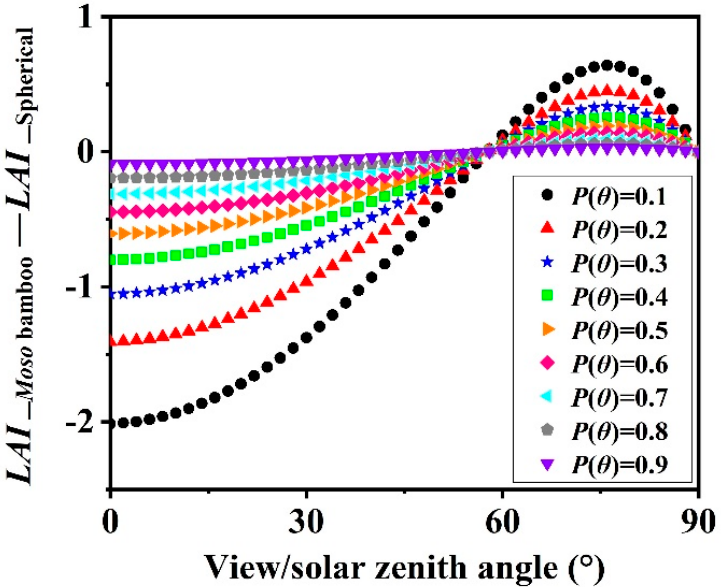
Figure 8. Leaf area index ( LAI ) differences between using the spherical angular distribution ( G ( θ ) ≈ 0.5) and the estimated leaf angle distribution of Moso bamboo.